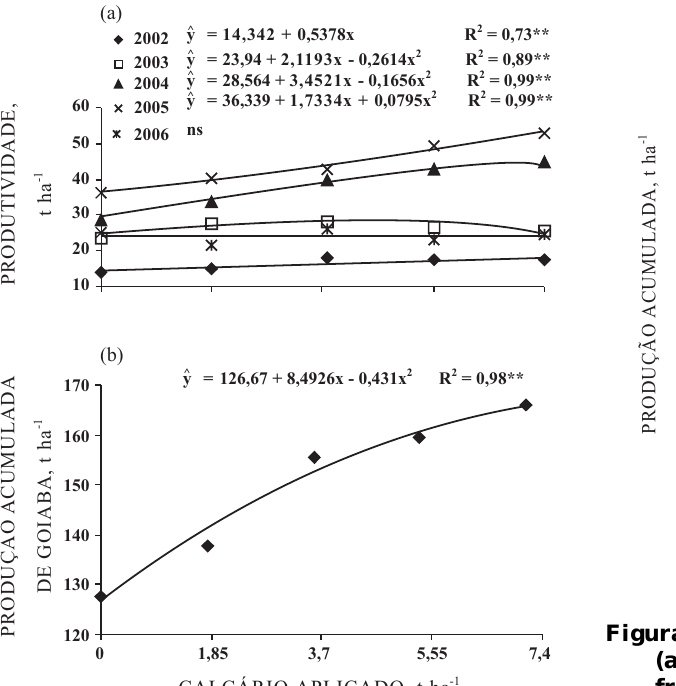
Figura 5. Efeito da aplicação de calcário dolomítico na produtividade de frutos de goiabeiras nas safras de 2002 a 2006 (a) e na produção acumulada de goiabas (b).